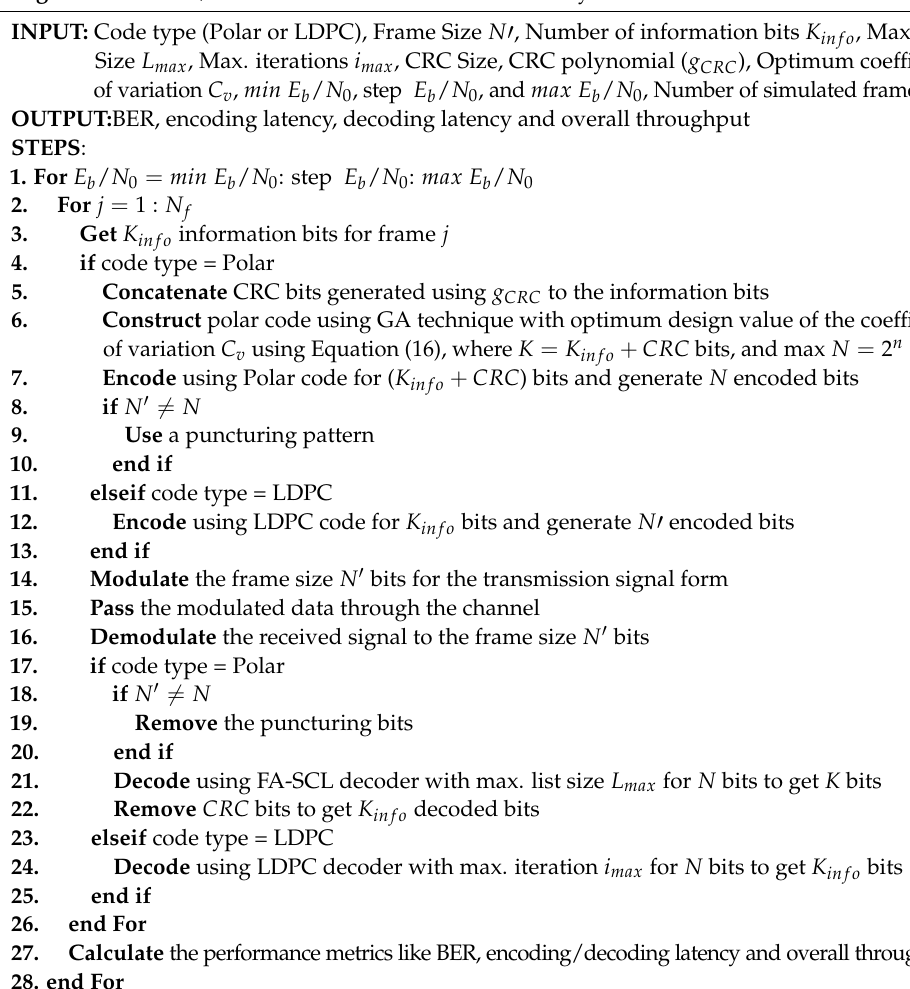
Algorithm 1 Polar / LDPC-based simulated transceiver